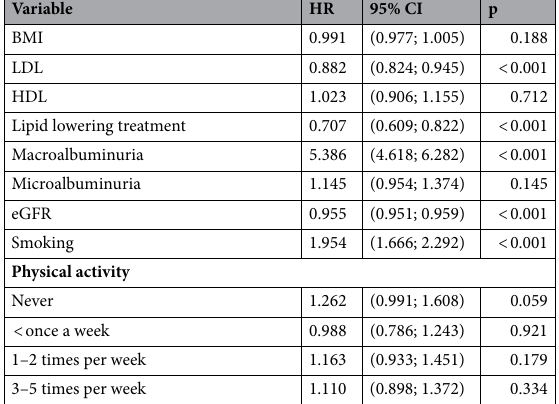
Table 3. Risk for comorbidity. Results from multiple Cox regressions used to evaluate risk factors predicting outcomes. BMI body mass index, HDL high density lipoprotein, eGFR estimated glomerular filtration